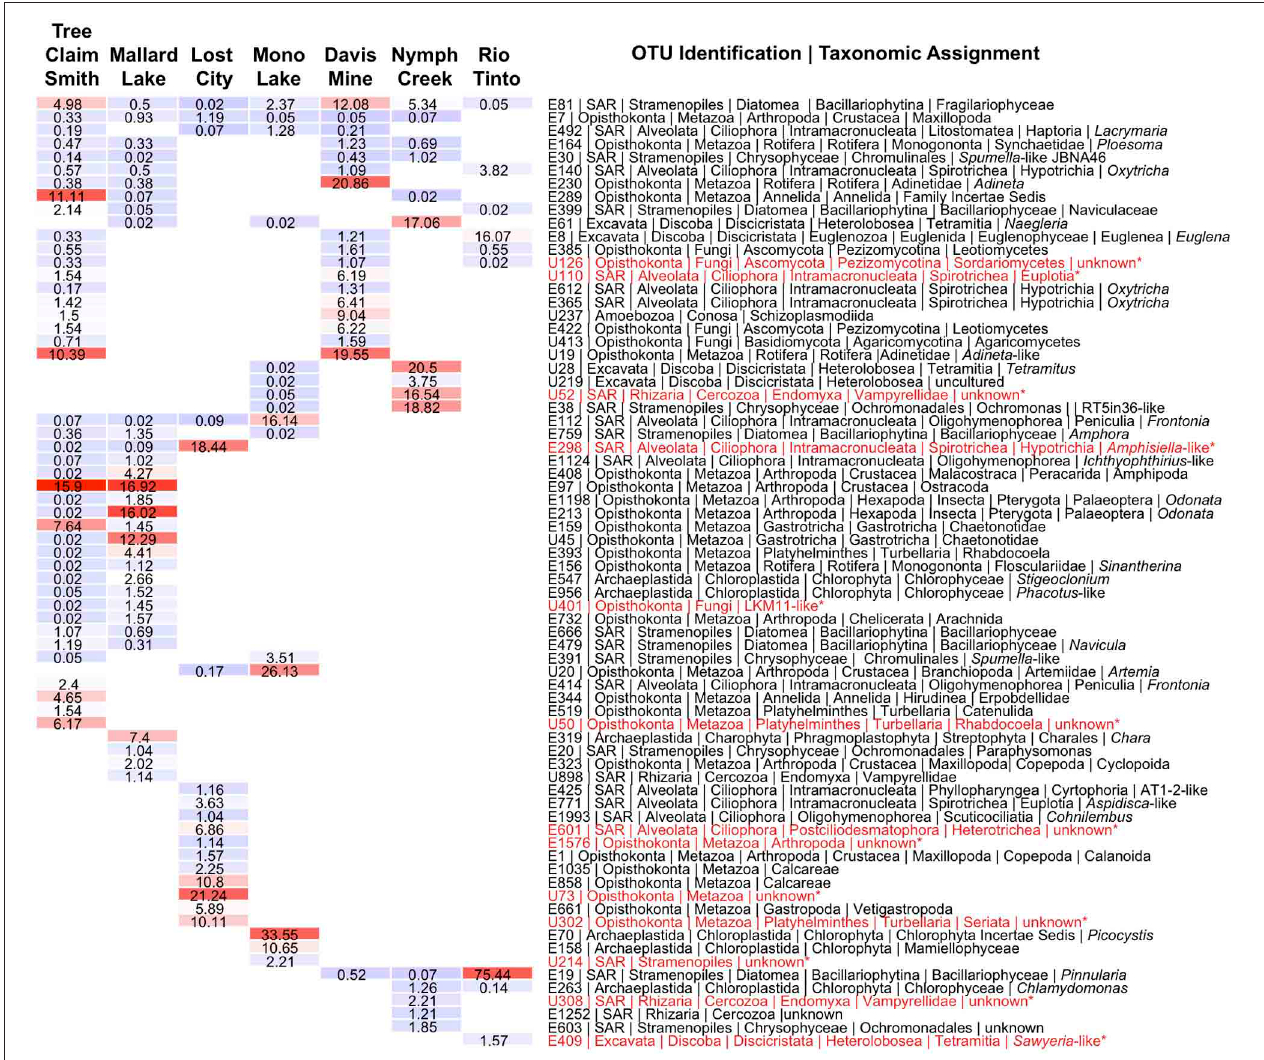
FIGURE 5 | Heatmap of OTUs occurring at a frequency of more than 1% at a given site. Alkaline sites are the four on the left and acidic sites the three on the right and are arranged in order of decreasing OTU richness from left to right. OTUs that occur at both alkaline and acidic sites are arranged at the top of the table from most to least cosmopolitan, while OTUs occurring at only alkaline or acidic sites are arranged below. Hot colors indicate higher